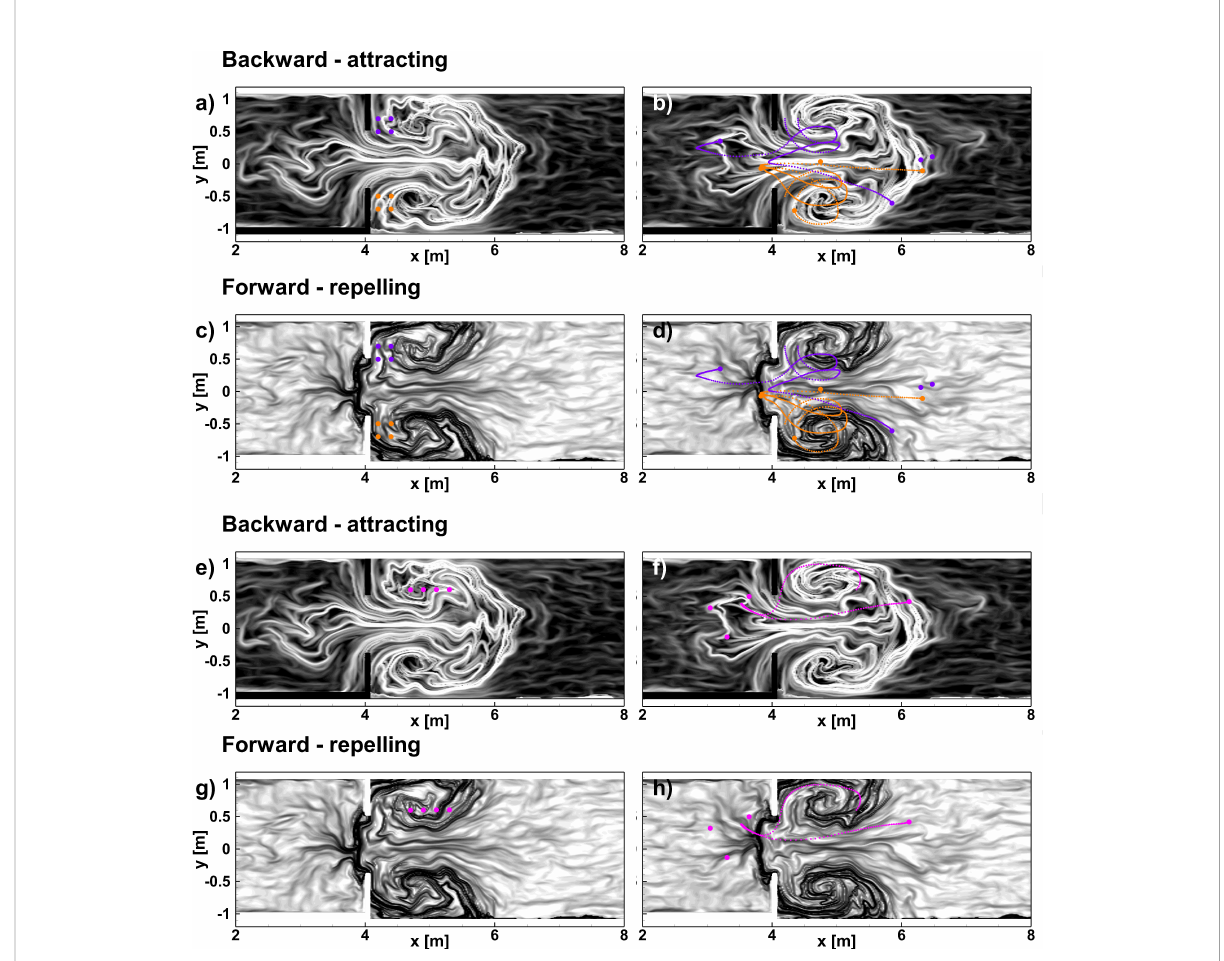
FIGURE 7 Panel (A) initial time of particle releasing 1 on backward FTLE fi eld; panel (B) fi nal time. Panel (C) initial time of particle releasing 1 on forward FTLE fi eld; panel (D) fi nal time. Panel (E) initial time of particle releasing 2 on backward FTLE fi eld; panel (F) fi nal time. Panel (G) initial time of particle releasing 2 on forward FTLE fi eld; panel (H) fi nal